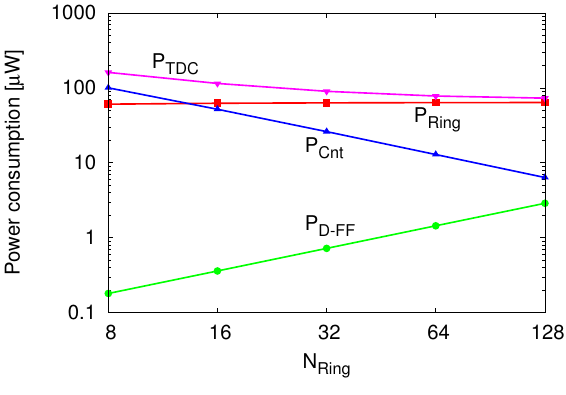
Figure 9. Simulation result of power consumption vs. N Ring during measurement.